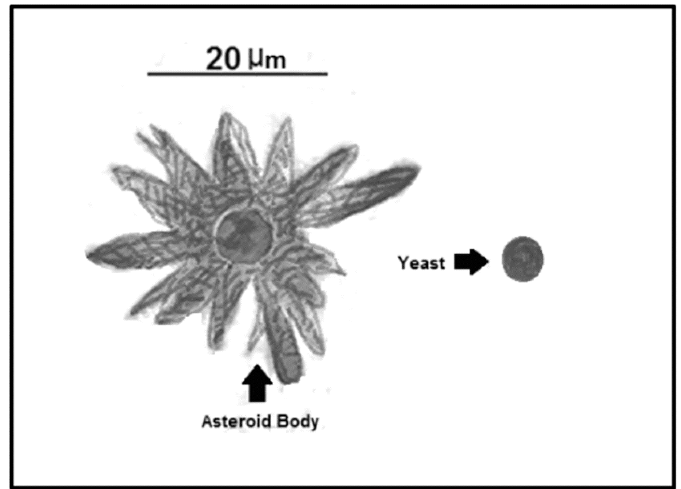
Figure 4. Representation of a Sporothrix schenckii asteroid body. Asteroid bodies can measure up to 100 µm, a bigger size when compared to the yeast form, which measures from 2 to 6 µm.